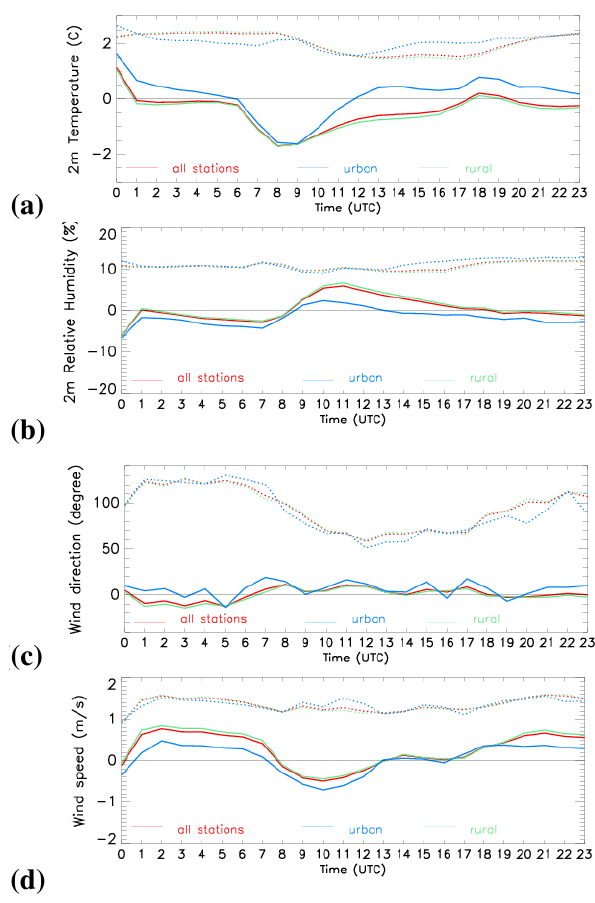
Fig. 3. Daily variation of the bias (solid line) and rmse (dashed line) for the REF simulations for the 2 m temperature (a), 2 m relative humidity (b), 10 m wind speed (c) and direction (d), considering all the stations (in red), or decomposed between urban (in blue) and rural stations (in green). Urban stations represent 35 stations over 235 stations for T2M, 33 stations over 182 stations for HU2M and 27 stations over 113 stations for the 10 m wind fields. for the REF simulation. In order to evaluate separately TEB and ISBA schemes, the scores are separated between urban and suburban stations on one side (corresponding to a town fraction greater than 0.1, leading to 35 stations over 235 for T2M) and rural stations (town fraction less than 0.1) on the other side. Statistical scores show a good behaviour of the REF simulation, with a bias less than 1.8 ◦ C for T2M, 6 % for HU2M, 0.8 ms − 1 and 20 ◦ for the wind speed and di- rection, respectively. The deviation from the measurements (rmse) is a bit higher. There is an indication of diurnal trend in the statistics of bias: for all stations (red curve), the pre- dicted atmospheric regime is slightly too cold and too wet during the day, but in very good agreement at night, as il- lustrated on Fig. 2 for 23 March at 04:00 and 11:00